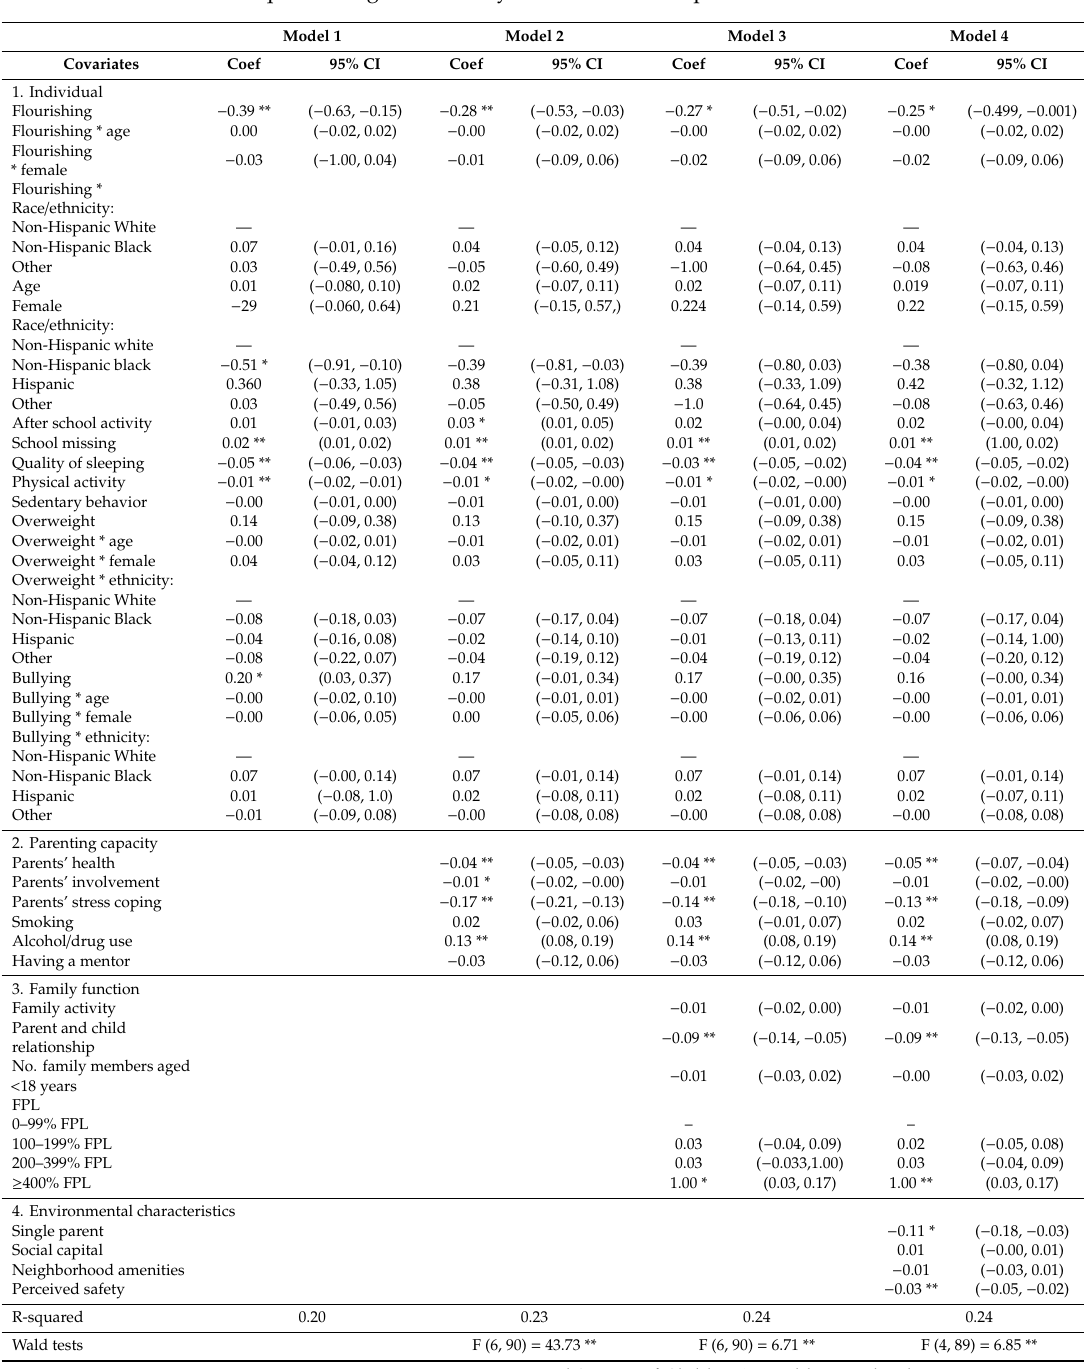
Table 2. Sequential regression analysis of children’s depression with